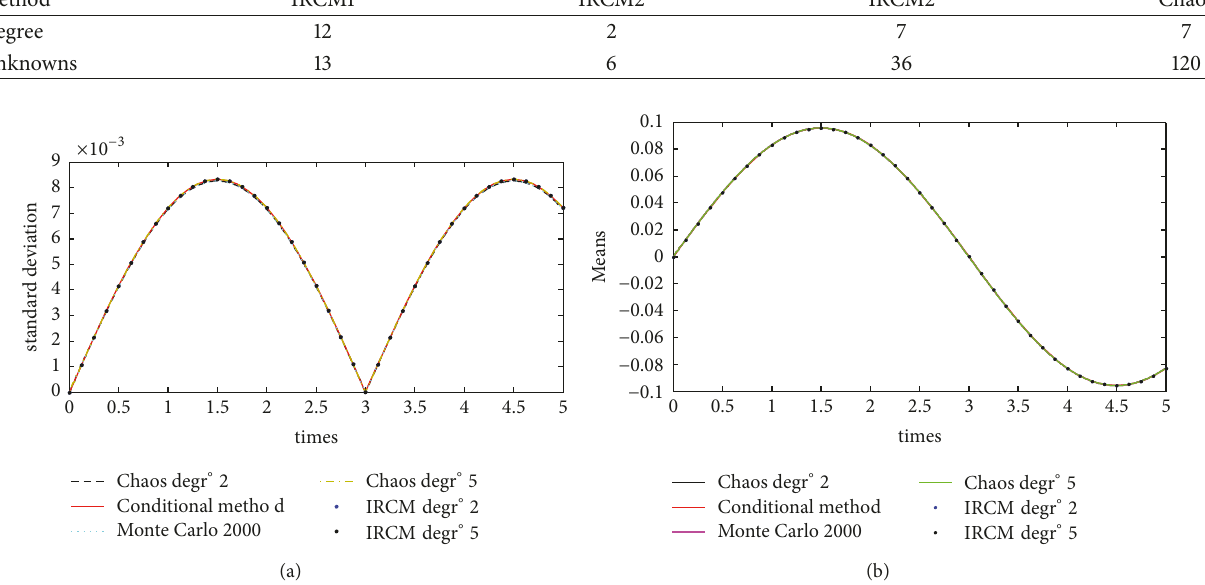
Figure 5: (a) Standard deviation of solution where 𝜉 0 and 𝜉 2 are truncated normal variables in [−4, 4] , 𝜉 1 is a uniform variable in [−1,1] , and 𝜉 3 is a truncated exponential variable in 𝜉 1 is a uniform variable in